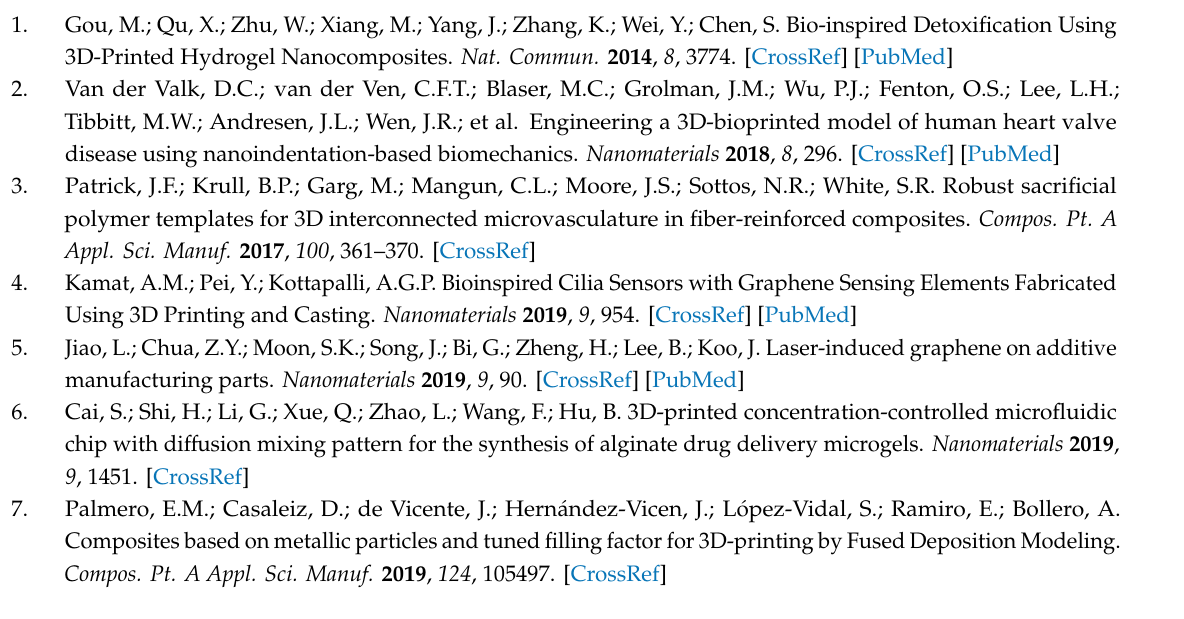
Figure S1: A detailed schematic illustrates of synthesis route of Ag-TNP. Figure S2: The step by step detailed preparation route of SLR / Ag-TNP nanocomposites. Figure S3: The digital image of the Dream 3D-C200 SLA 3D printing device, which was utilized for this research work. Figure S4: XPS spectrum analysis of as-prepared TiO 2, and Ag / TNP (a) survey spectrum (black spectrum represents TiO 2 and red spectrum represents Ag-TNP), (b) Deconvoluted XPS spectra of Ti, and (c) Deconvoluted XPS spectra of Ag, (c) Deconvoluted XPS spectra of O. Figure S5: A real-time FTIR analysis of photopolymerization of (a) neat SLR, (b) SLR / Ag-TNP-0.5, (c) SLR / Ag-TNP-0.8, and (d) SLR / Ag-TNP-1.2, nanocomposites in di ff erent periods of time intervals starting from 0 s to 600 s under the UV irradiation power of 32 mW / cm 2 . Figure S6: (a) percentage conversion graph of SLR / Ag-TNP-1 nanocomposite in di ff erent power densities of UV-irradiation monitored by RT-FTIR. (b), (c), and (d) are real-time FTIR analysis of photopolymerization of SLR / Ag-TNP-1 nanocomposites in di ff erent periods of time intervals starting from 0 s to 600 s under UV irradiation power densities of 24 mW / cm 2 , 28 mW / cm 2 and 32 mW / cm 2 , respectively. Figure S7: (a) real-time FTIR analysis of SLR / TNP-1 nanocomposite and (b) percentage conversion graph of photopolymerization of SLR / TNP-1 nanocomposite (black line) and SLR / Ag-TNP-1 (red line) nanocomposite, under the UV irradiation power of 32 mW / cm 2 in di ff erent periods of time intervals starting from 0 s to 600 s. Table S1: The composition of mixture used for SLA photoresin